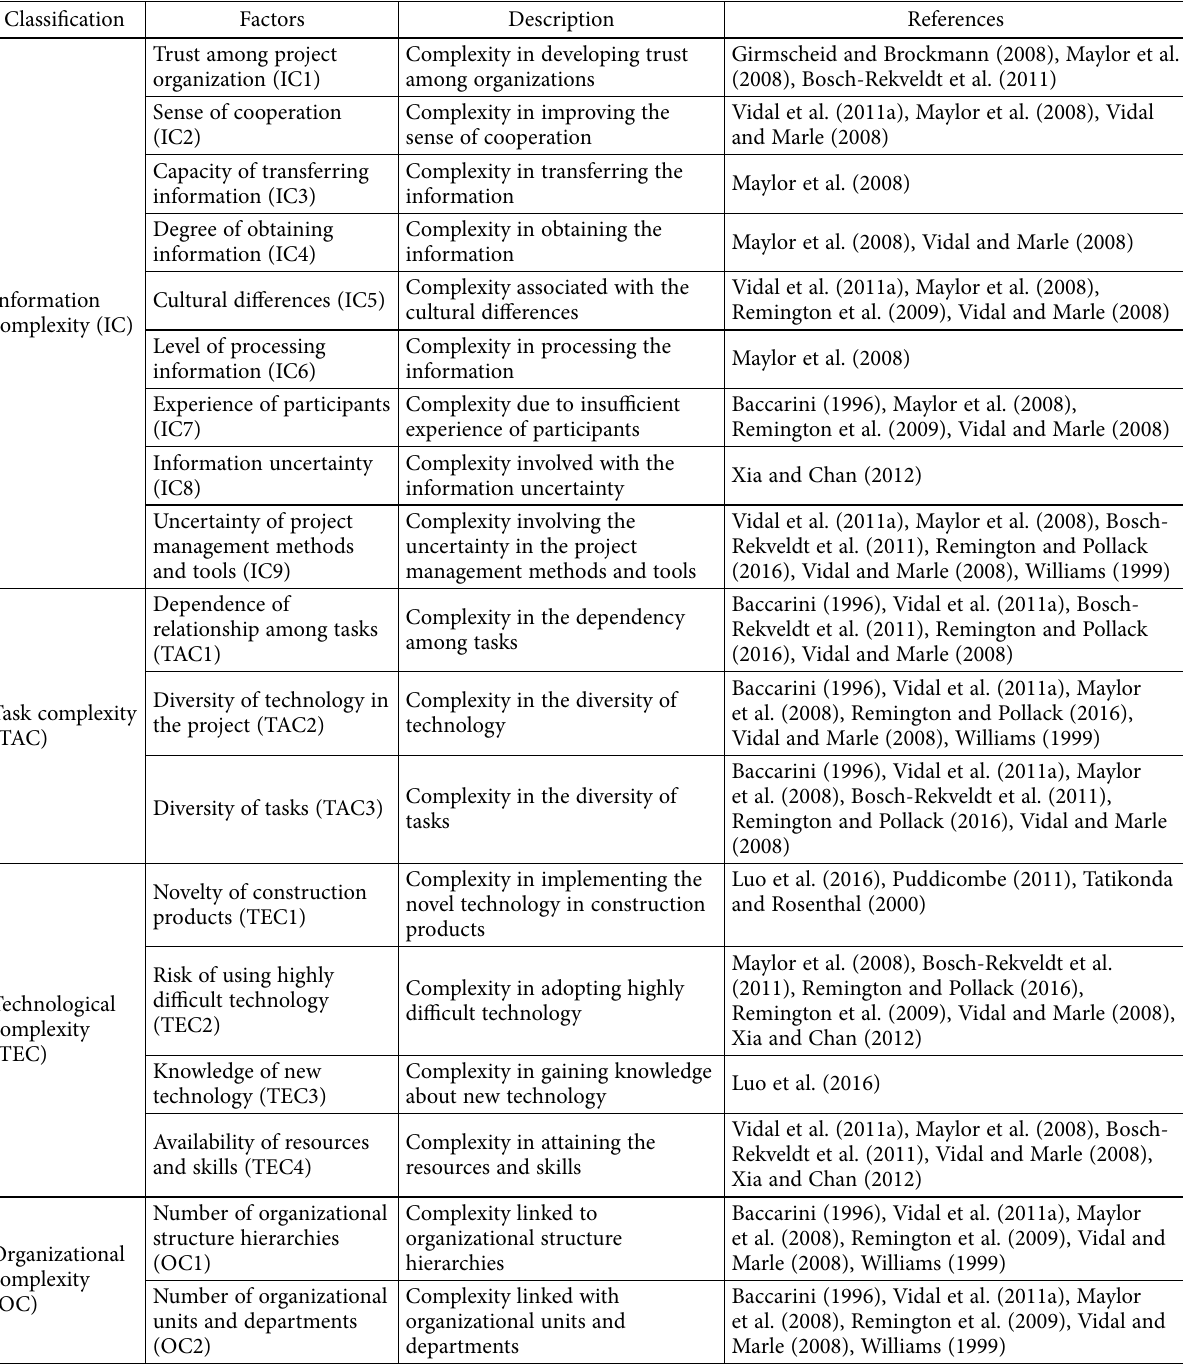
Table 2. 26 complexity factors based on the literature